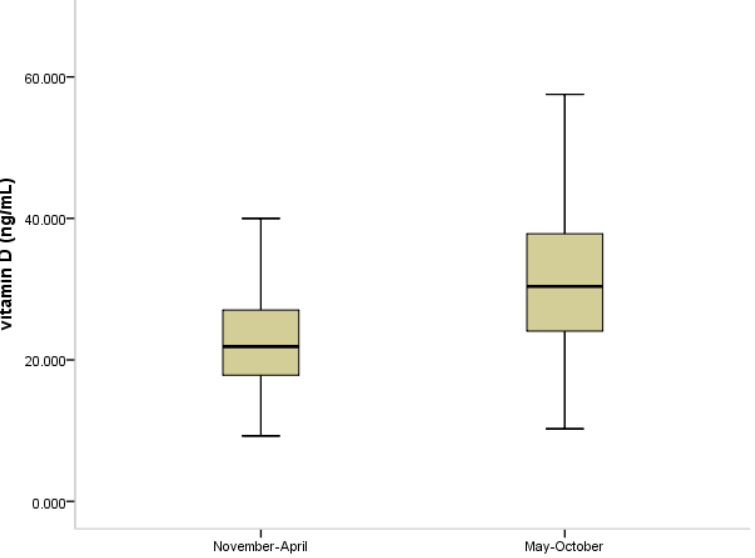
Figure 2. Box plot showing the level of vitamin D (25(OH)D, ng/mL) in children and adolescents with and without atopy ( n = 340) according to season. Data are expressed as median, p < 0.001.